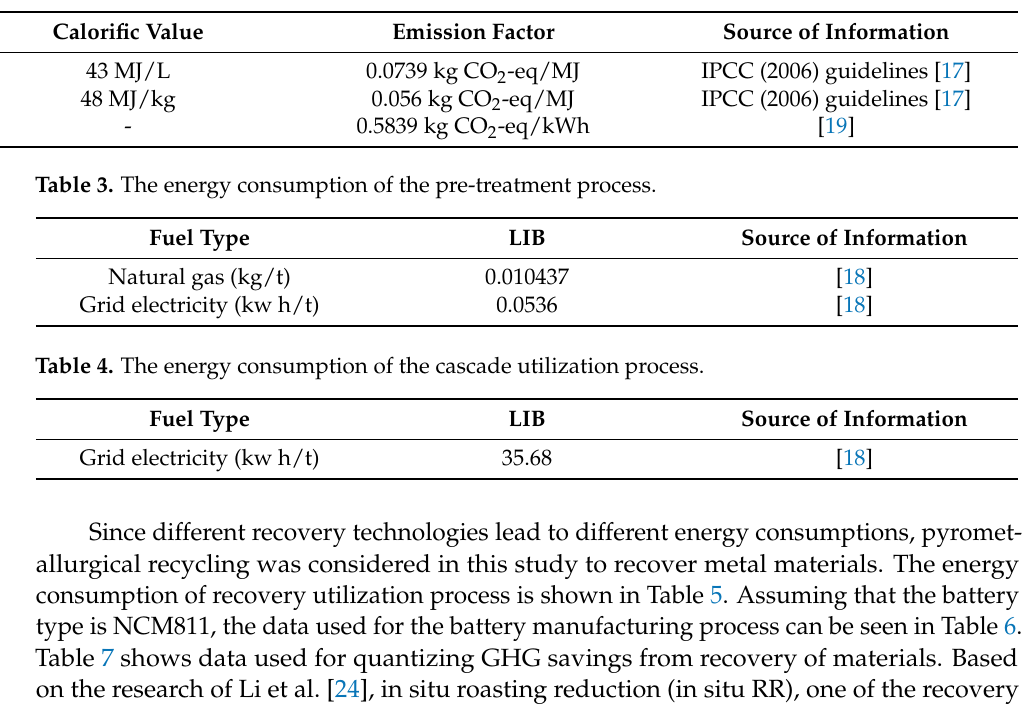
Table 2. The calorific values and emission factors of various fuels.